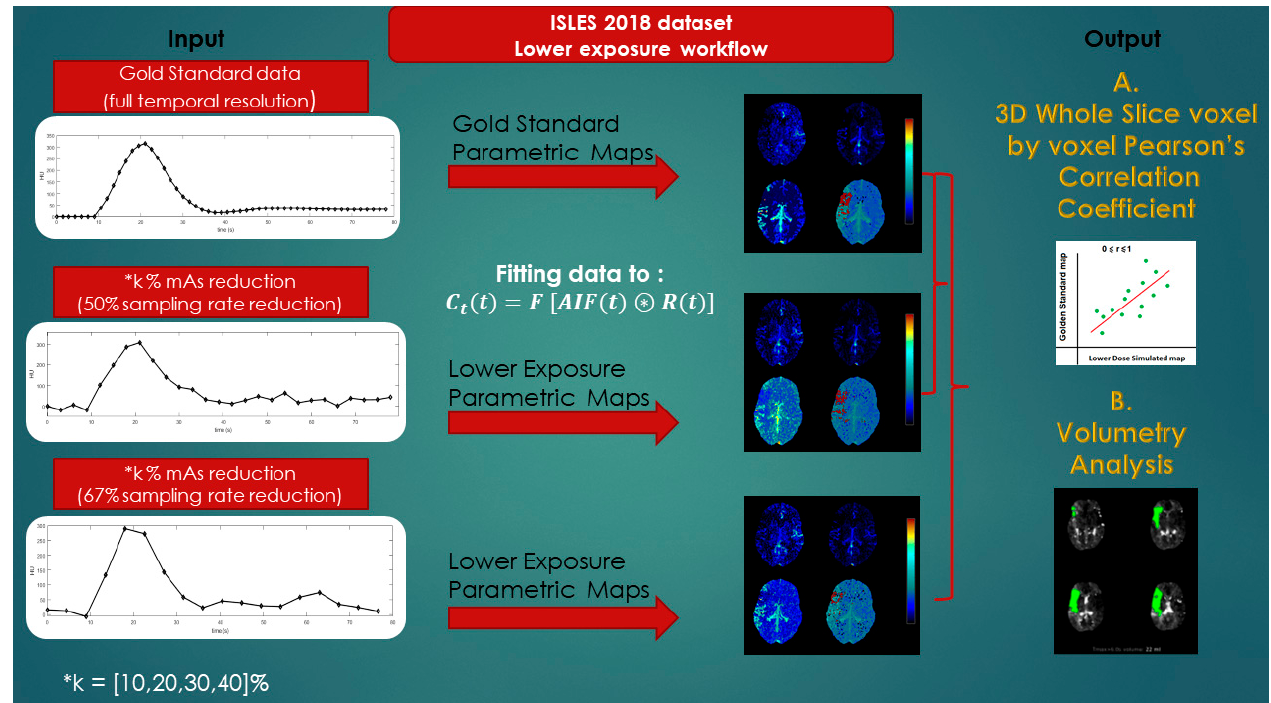
Figure 2. Lower-exposure workflow.